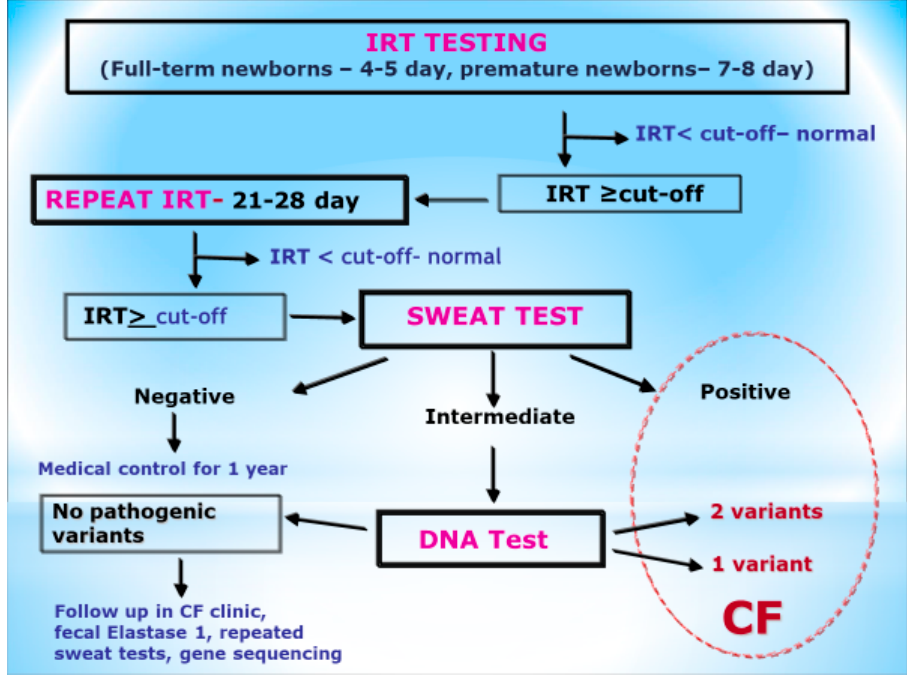
Figure 1. The algorithm of newborn screening for cystic fibrosis in Russia.